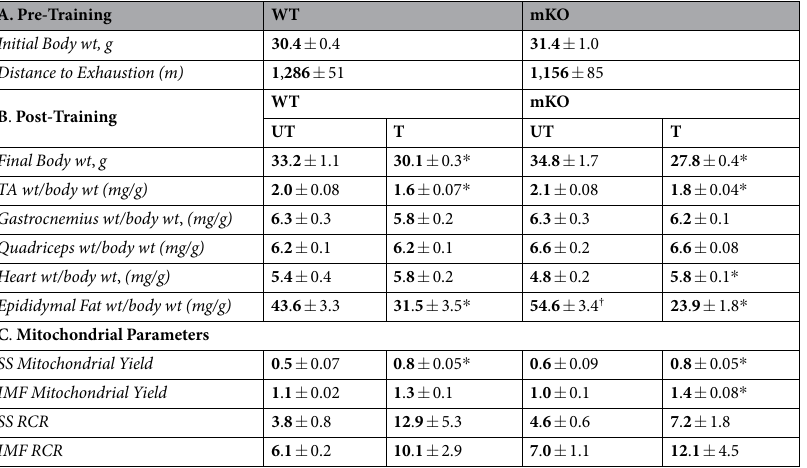
Table 1. Phenotypic alterations and exercise capacity under basal and exercise training conditions. ( A ) Pre-training variables (initial body mass and distance to exhaustion) were compared between genotype in the muscle specific (n = 13–23/group). ( B ) Phenotypic variables were measured following the training or sedentary program (n = 6–10/group); * p ≤ 0.05, UT vs. T; † p ≤ 0.05, WT vs. mKO, 2-way ANOVA and Student’s t-test. ( C ) Mitochondrial parameters measured in SS and IMF mitochondrial subfractions (n = 5–10/group); * p ≤ 0.05, UT vs. T, 2-way ANOVA and Student’s t-test. Data are presented as mean ± SEM. Abbreviations: RCR, respiratory control ratio; TA; tibialis anterior; SS, subsarcolemmal; IMF,